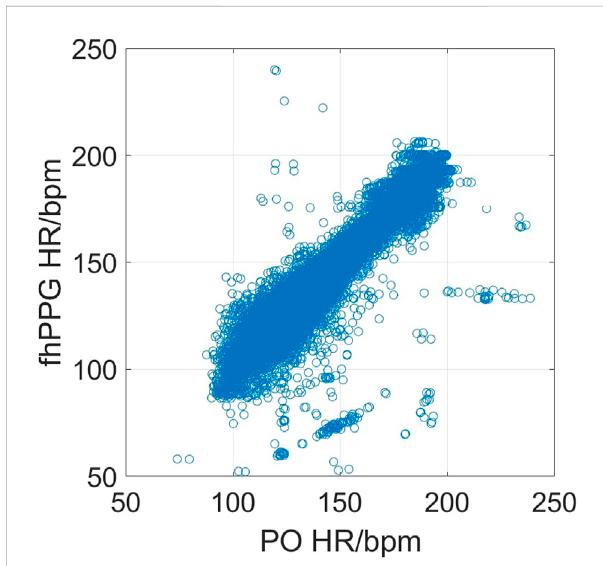
FIGURE 3 Scatter plot of heart rate between PO vs. fhPPG (n = 142,567) for 19 subjects.